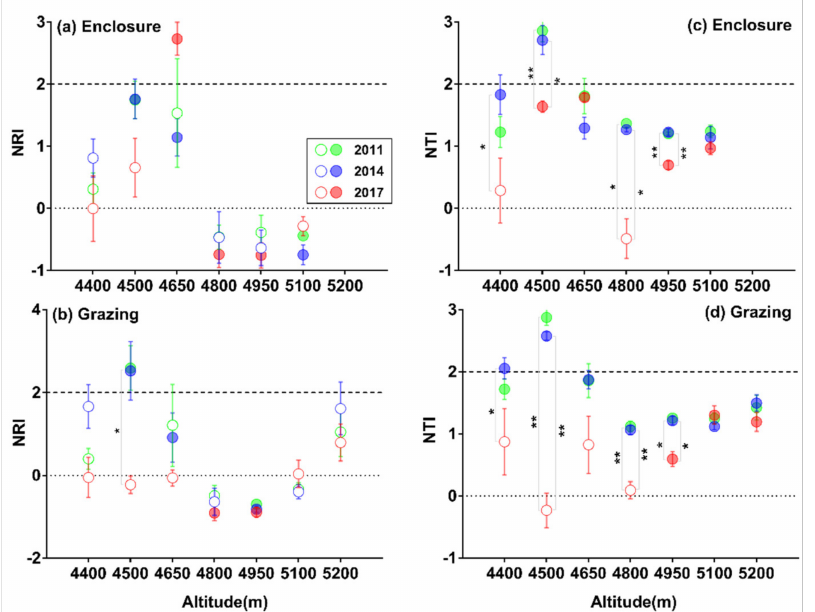
Figure 3. Dynamic variations of effects of enclosure and grazing on ( a , b ) net relatedness index (NRI) and ( c , d ) nearest taxon index (NTI) along the altitudinal gradient. Blank and solid circles denote insignificant and significant differences from zero in NRI or NTI of each year based on one-sample t test, respectively. Asterisk denotes the significant differences in NRI among different years. * P < 0.05, ** P < 0.01, *** P < 0.001.